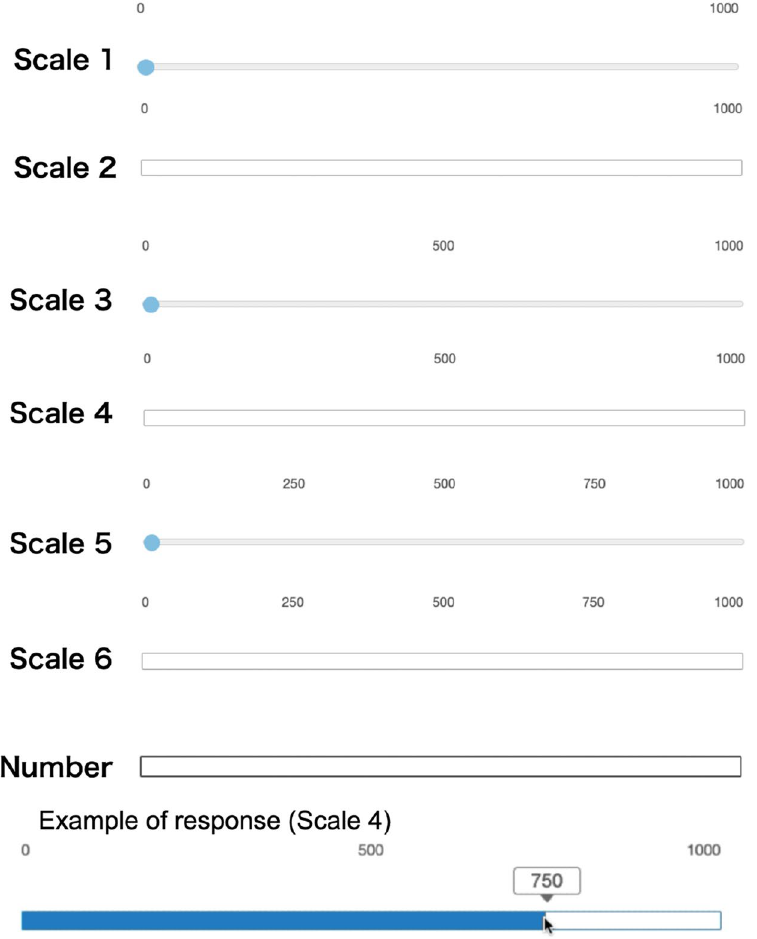
Figure 3. Response format in numerical